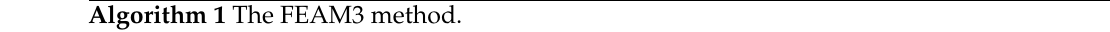
Algorithm 1 The FEAM3